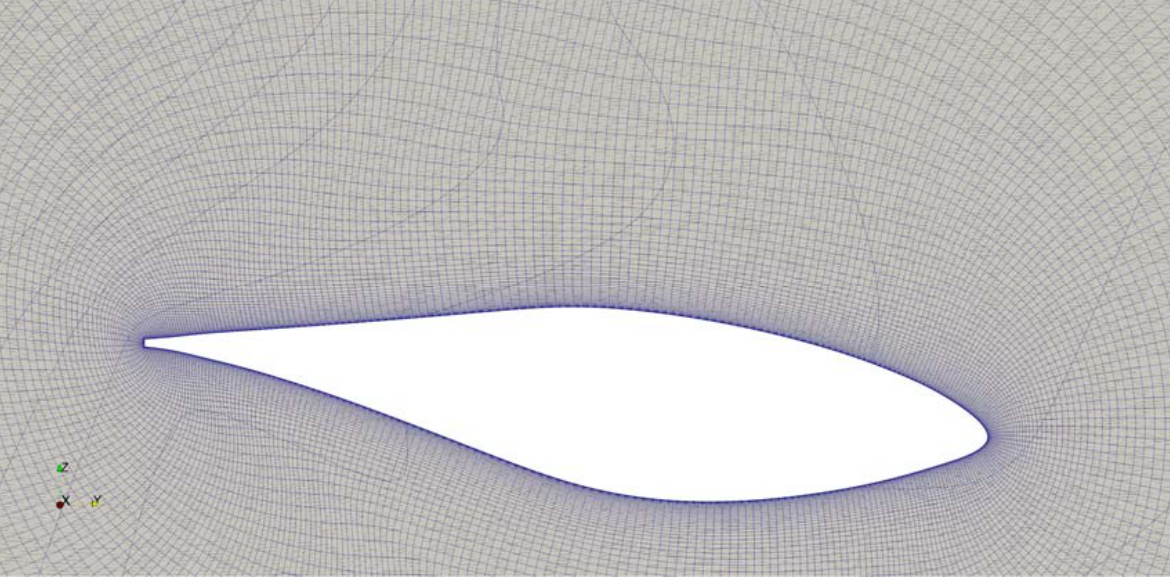
Figure 10. Hyperbolic boundary layers of the NREL Phase VI wind turbine (side view). Table 2. Mesh convergence